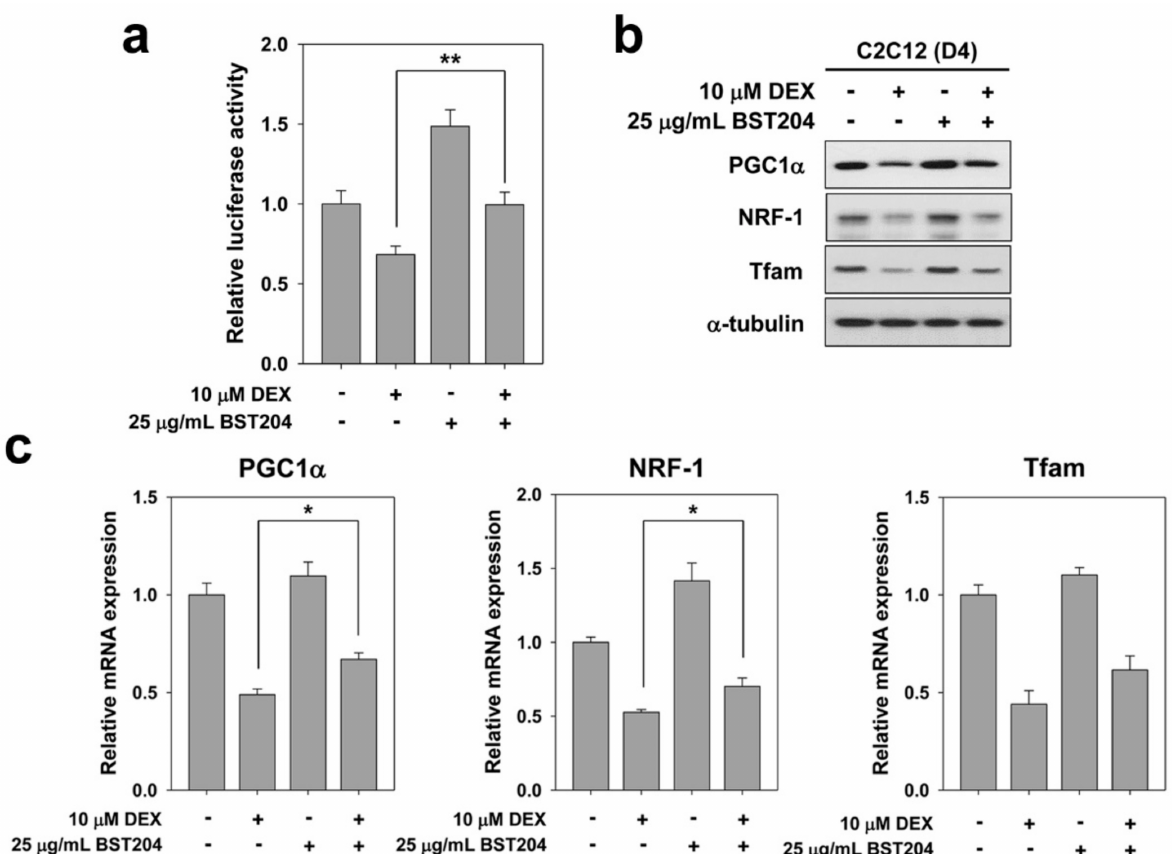
Figure 4. BST204 upregulates the PGC1 α activity in DEX-induced atrophic myotubes. ( a ) C2C12 cells were transiently transfected with a PGC1 α -responsive luciferase reporter. After 24 h, these cells were induced to differentiate in the presence of 10 µ M DEX, along with vehicle or 25 µ g/mL BST204 for an additional 1 day, followed by luciferase assay. ** p < 0.01 compared with DEX-treated group. ( b ) C2C12 cells were induced to differentiate in DM for 3 days, followed by the treatment with 10 µ M DEX along with vehicle or 25 µ g/mL BST204 for 1 day. These cell lysates were then subjected to immunoblotting analysis. The experiment was repeated three times with similar results. ( c ) Quantitative RT-PCR analysis for PGC1 α , NRF-1 and Tfam in C2C12 cells treated with 10 µ M DEX, along with vehicle or 25 µ g/mL BST204 at D2. All values from control sample were set to 1.0. Data from three independent experiments were presented as the means ± SD. Significant difference from DEX-treated group, * p <